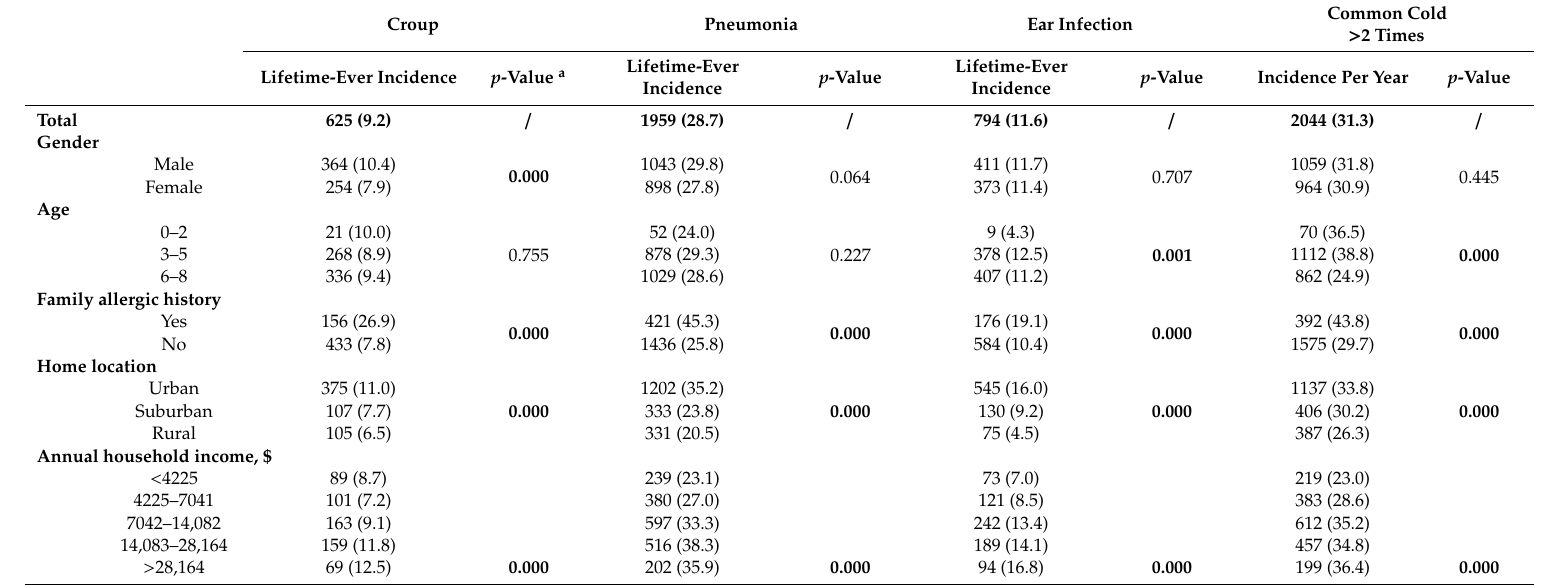
a p -value in Pearson chi-square test. Bold indicates statistical